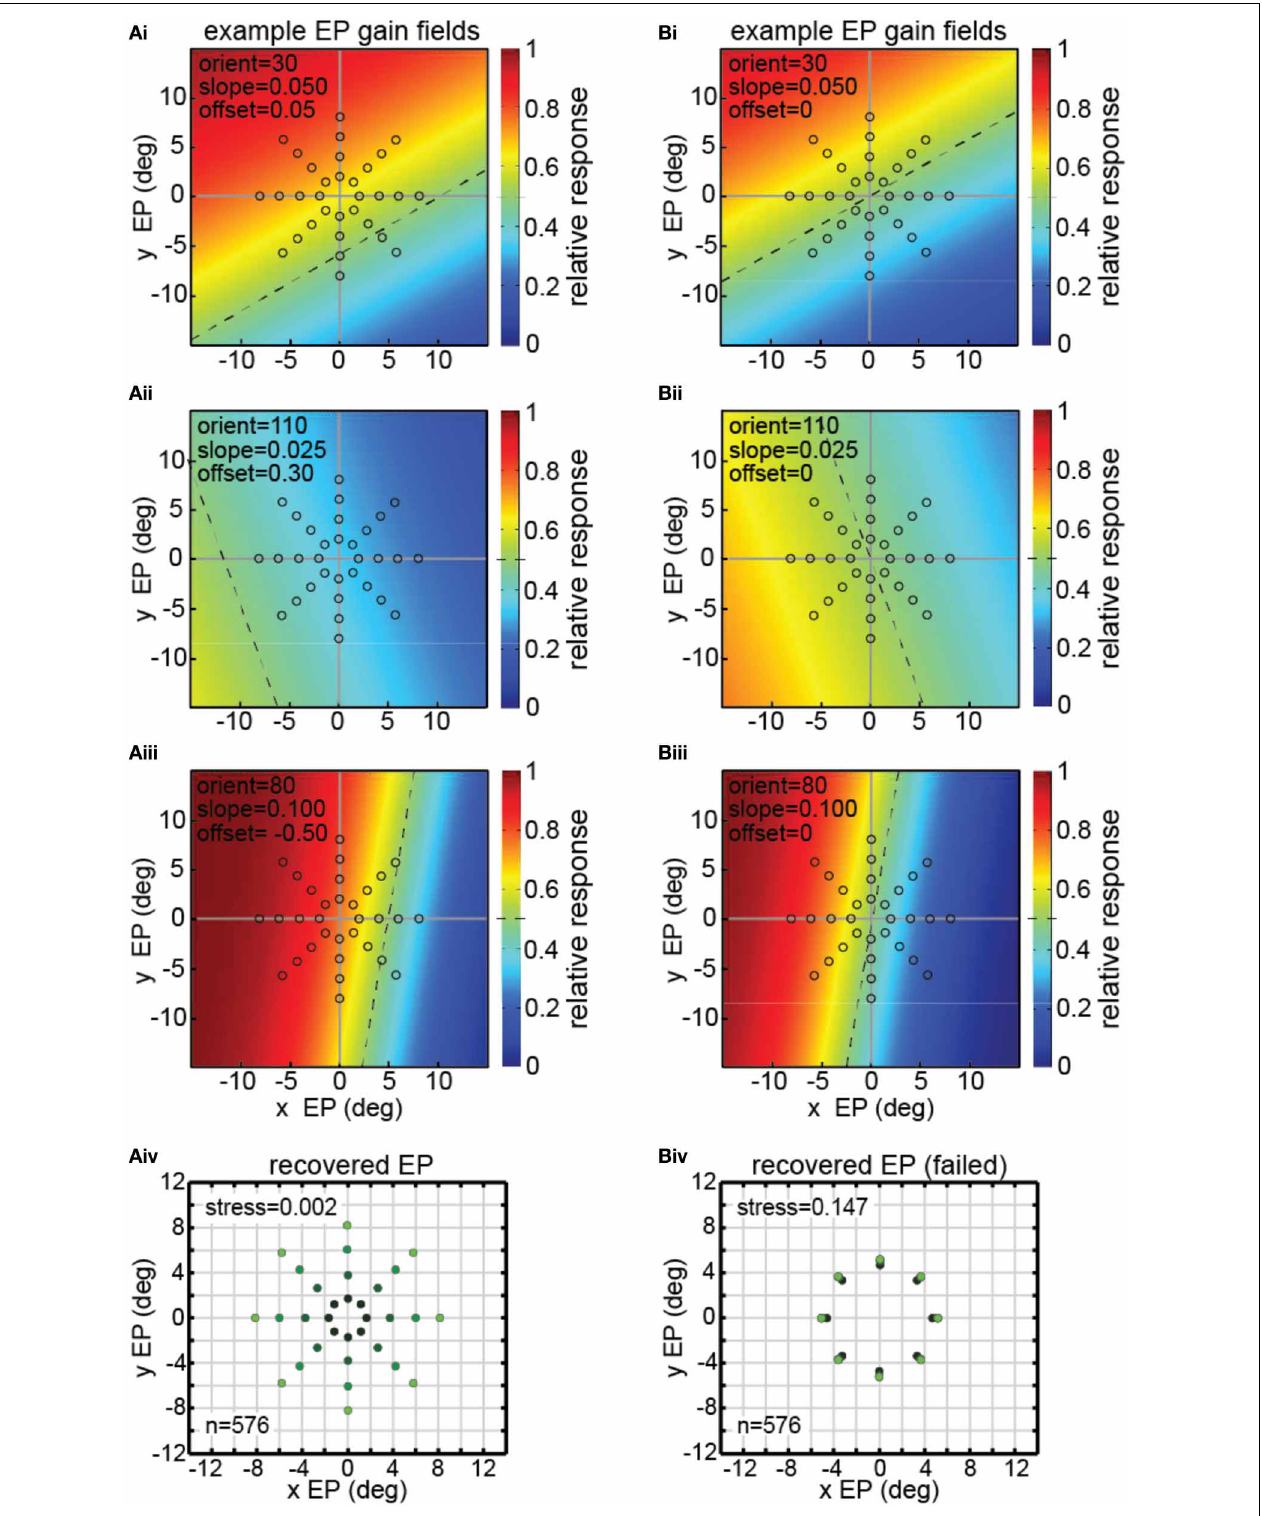
FIGURE 8 | Model results showing decoding of eye position, using multidimensional scaling on a population of model neurons with diverse eye-position gain fields. Population consisted of 576 neurons, each with a different gain field. Gain fields were defined by three parameters: